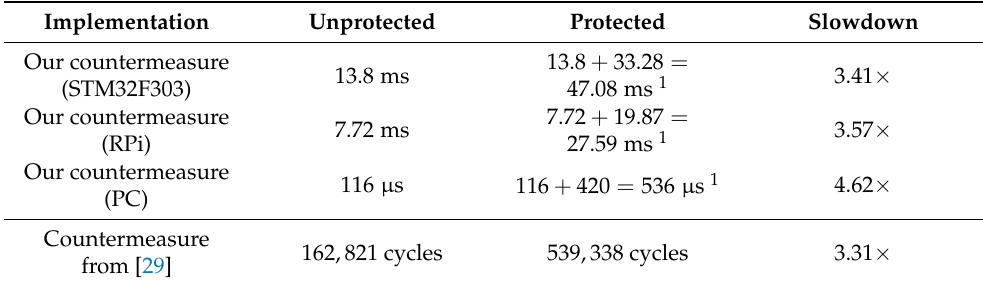
Table 2. Time overhead